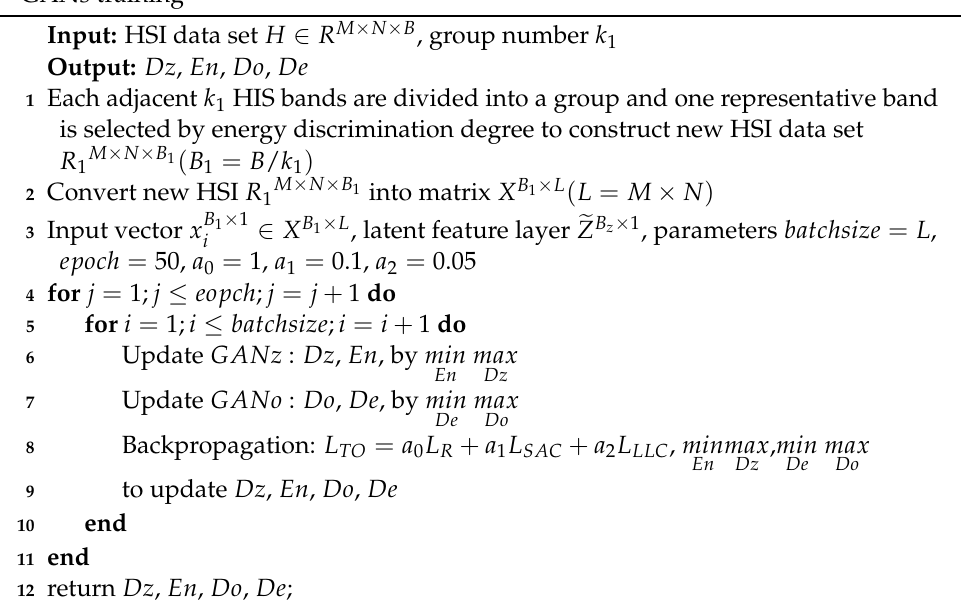
Algorithm 1: Background spatial feature enhancement-based constrained two GANs